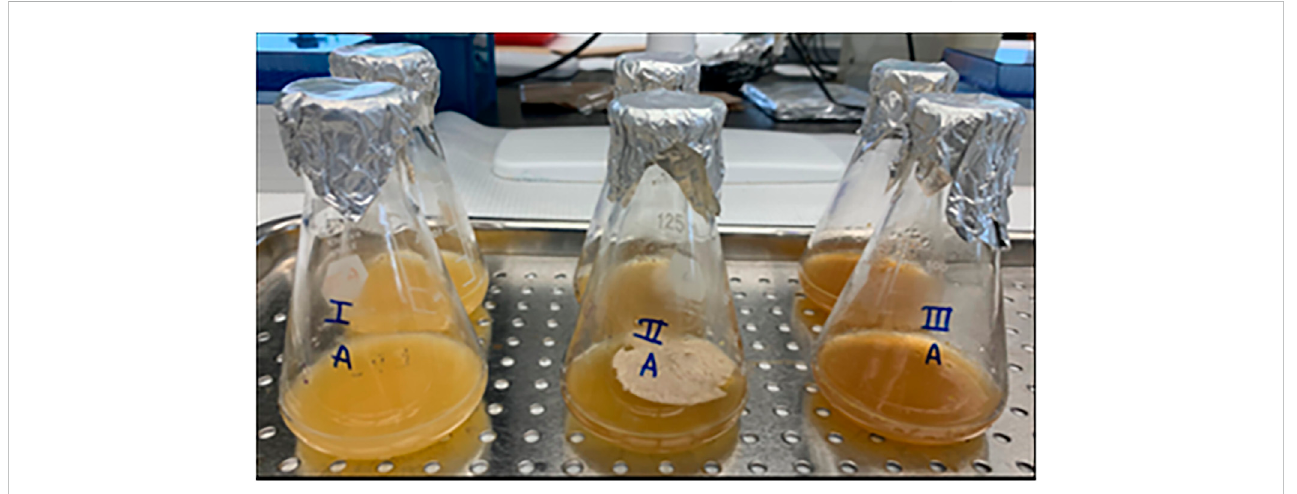
Presence of microorganism growth at the surface of pasteurized corn-DDGS extracts. I- untreated extract, II- pasteurized extract (70 ° C for 15 min), and III- autoclaved extract (121 ° C for 20